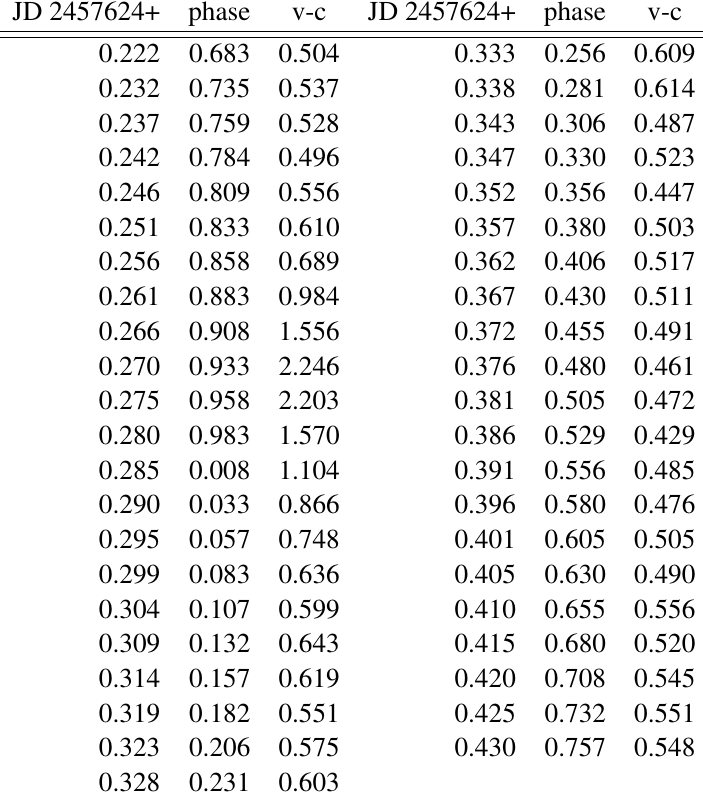
Table 6 list of CCD Photometry of DQ Her in I filter.